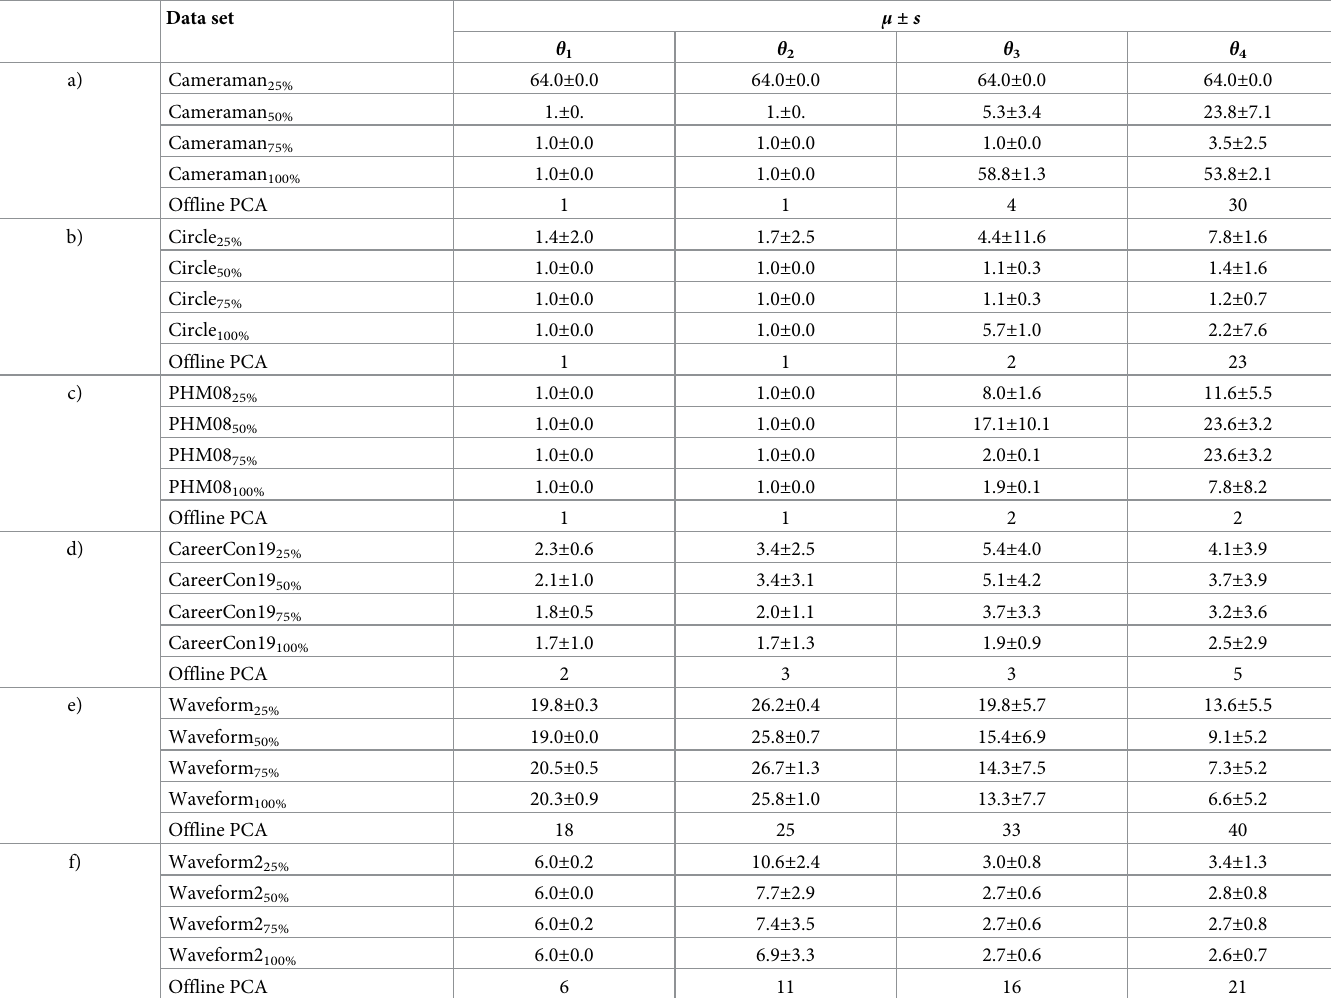
Table 6. Results of the incremental PCA [8] on the cumulative energy stopping rule: θ 1 = 0.7, θ 2 = 0.8, θ 3 = 0.9, θ 4 = 0.99. Data